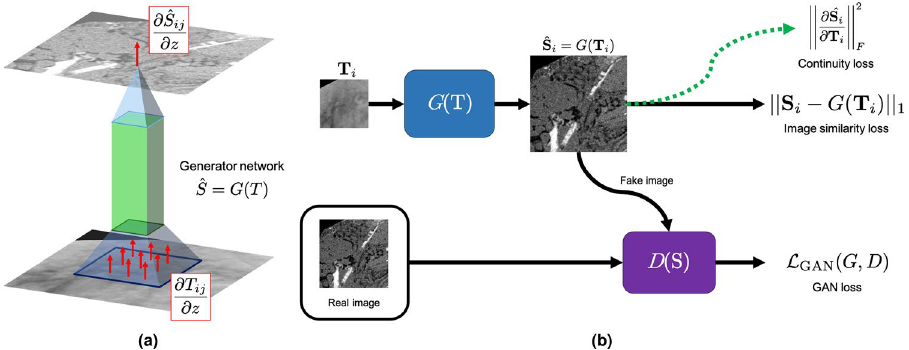
Figure 2. Image translation model. ( a ) Visualization of the Jacobian regularization approach proposed to improve volume prediction with 2D-to-2D models. z -direction gradients are assumed to be sparse and we encourage continuity in the input TXM pixels T ij by penalizing the training by the Jacobian of the output image with respect to the input. ( b ) SRGAN image-to-image deep learning model. The model is trained with a vanilla or Wasserstein GAN loss, L 1 image similarity loss, and optionally the proposed Jacobian loss to encourage continuity between input TXM slices. Software: Powerpoint www. micro soft.